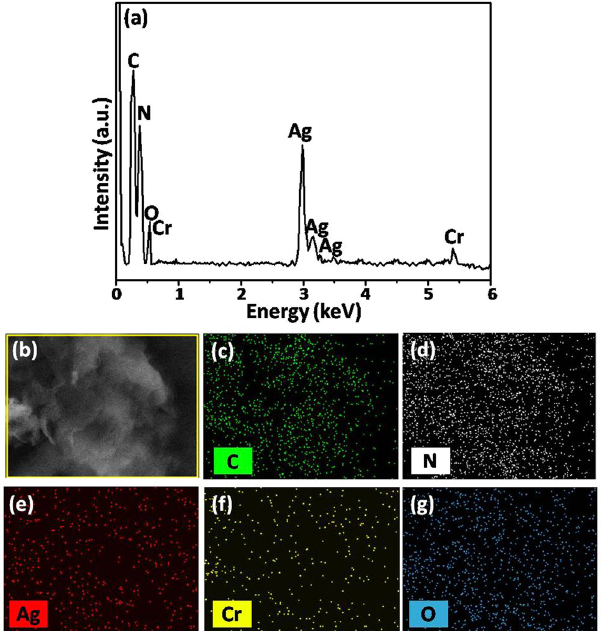
Figure 4. ( a ) EDS spectra for the g-C 3 N 4 /Ag 2 CrO 4 (23.1%), ( b ) SEM of g-C 3 N 4 /Ag 2 CrO 4 (23.1%), ( c – g ) EDS mapping for different elements of the